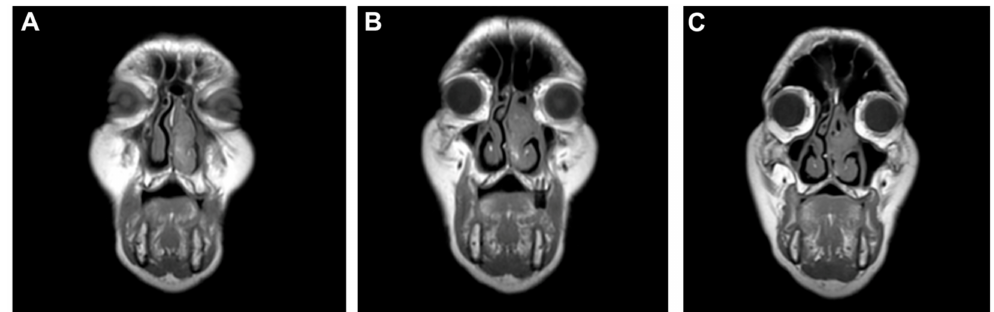
Figure 1. MRI T1 weighted images of the facial sinuses (coronal plane). ( A ) Polypoid voluminous mass extending throughout the left nasal cavity. ( B , C ) The tumor occupies the middle meatus and anterior side of the superior and inferior left